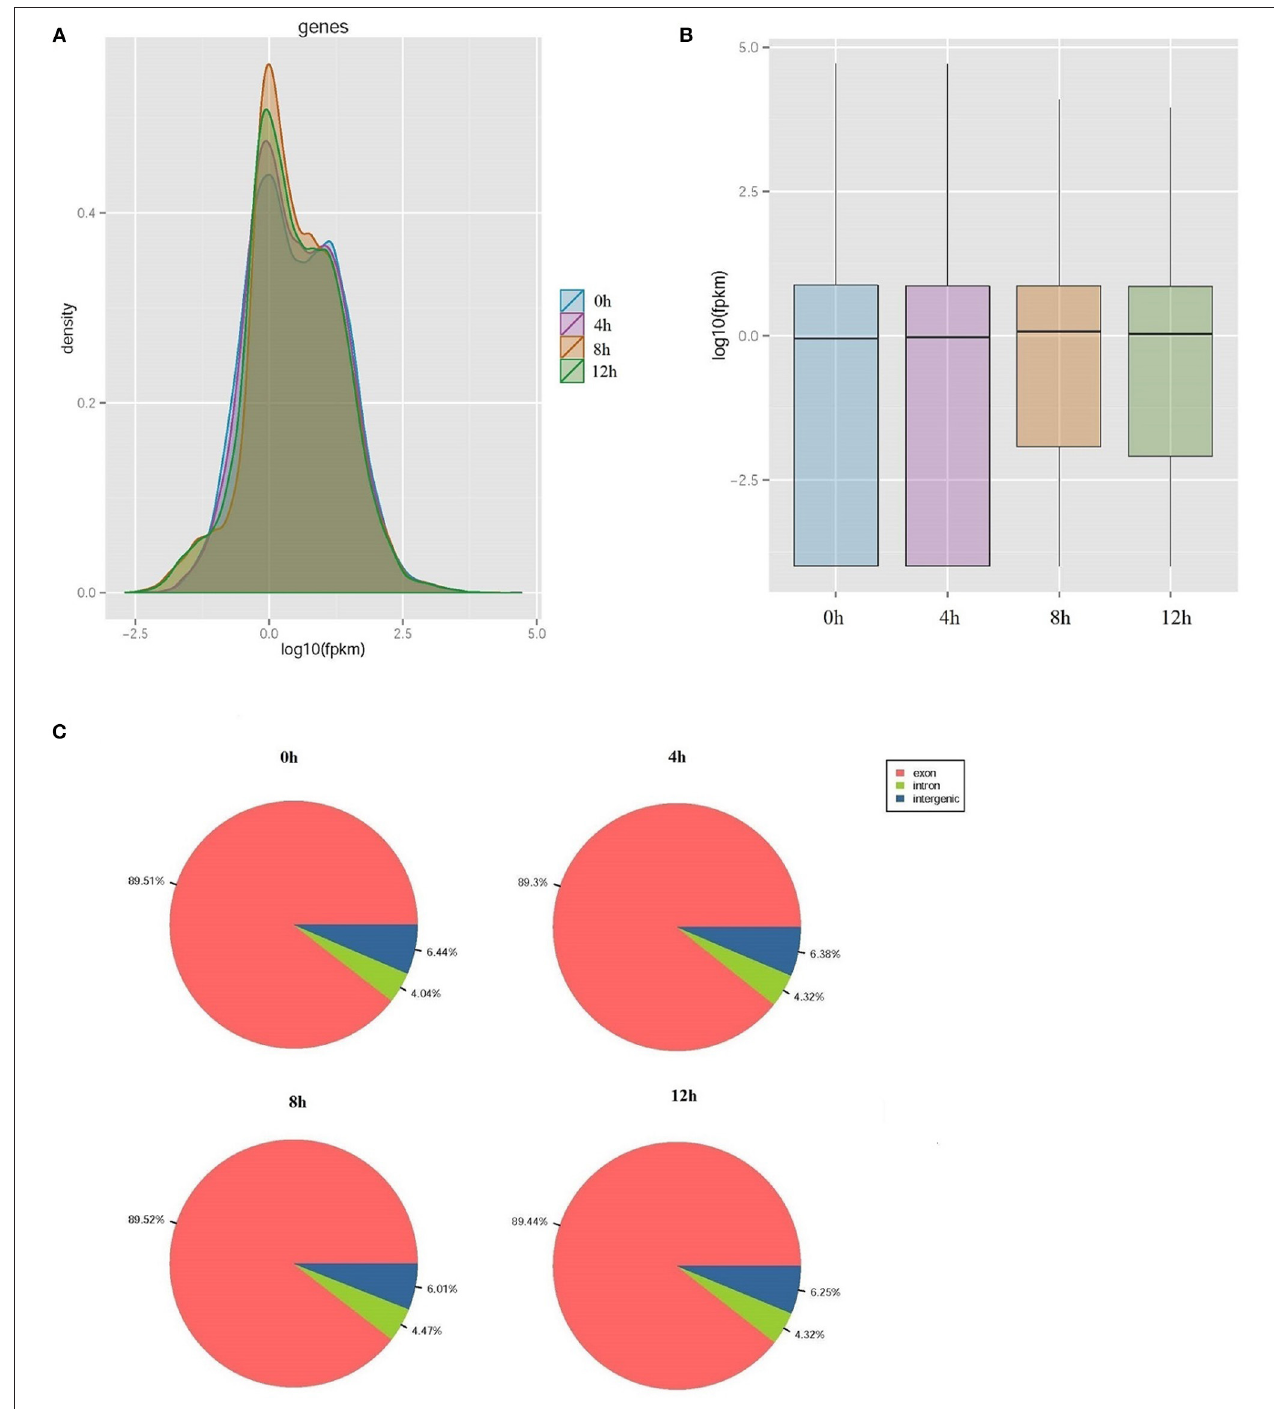
FIGURE 1 | Overview of transcriptome sequencing data. (A) The relative expression density of transcripts; (B) The relative expression level of transcripts; (C) The genome distribution of clean reads in lipopolysaccharide (LPS)-induced bovine mammary epithelial cells at 0, 4, 8, and 12h, respectively.